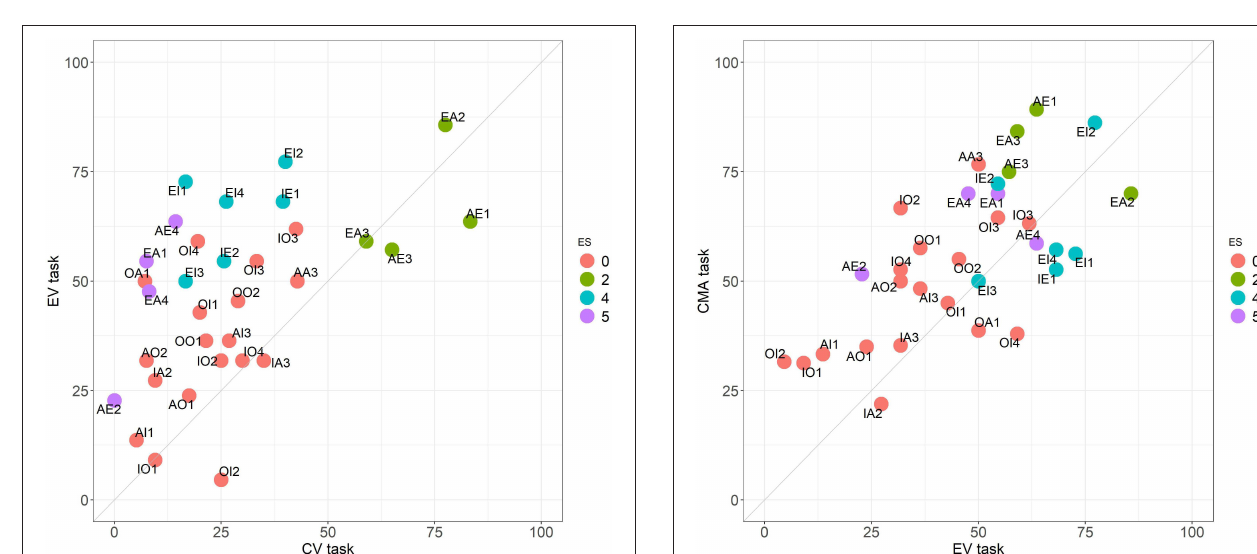
FIGURE 4 | Comparison between the EV and the CMA tasks. Performance across the 32 problems. Colors follow the ES